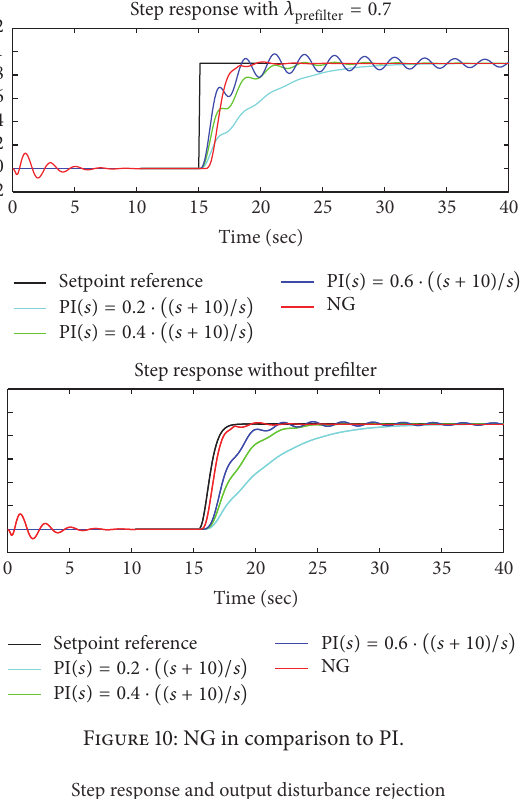
Figure 10: NG in comparison to PI.